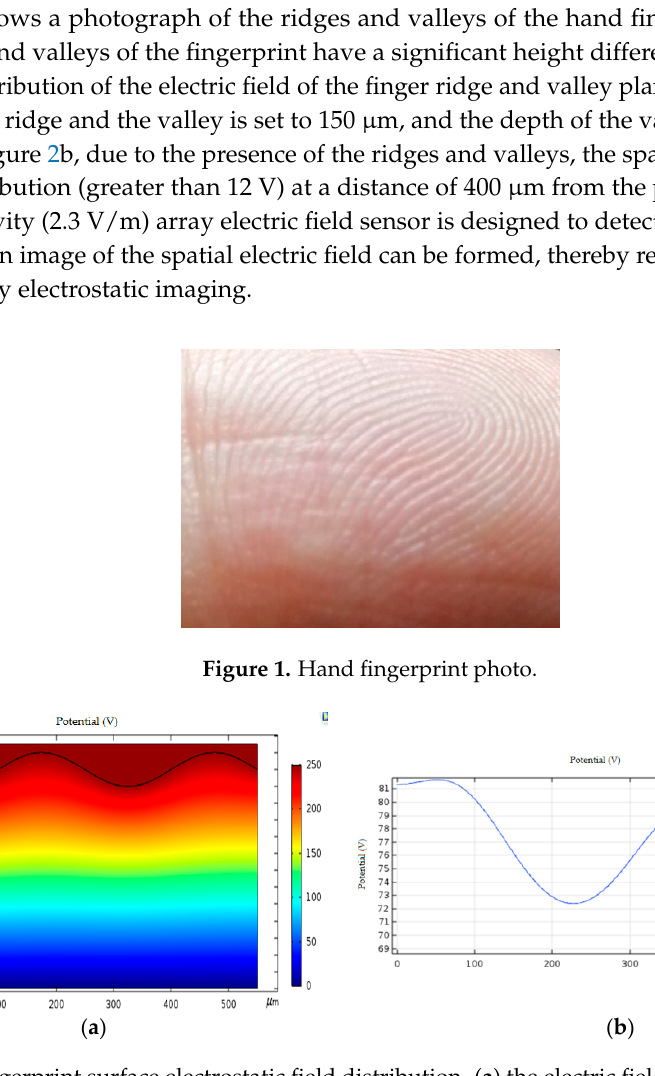
Figure 2. Fingerprint surface electrostatic field distribution. ( a ) the electric field distribution; ( b ) the electric field strength.